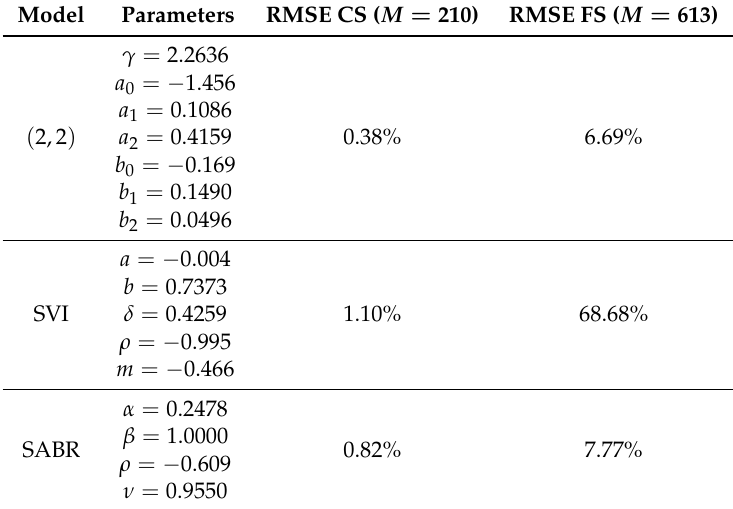
Table 2. RMSE of estimated implied volatility surfaces in the calibration sample (CS) and the full sample (FS).